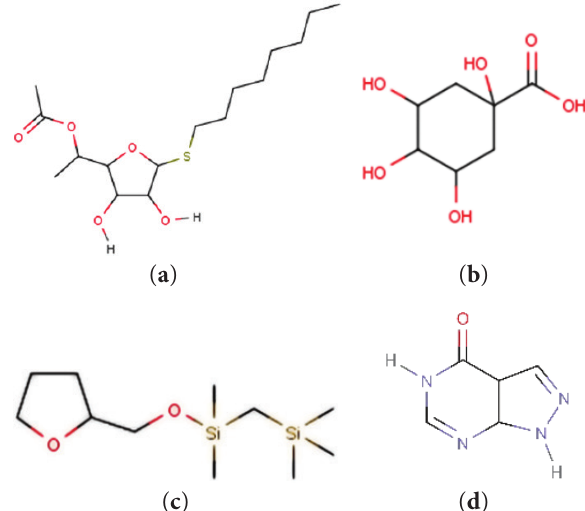
Figure 1. The compounds’ chemical structure of ( a ) 5-O-ace- tyl-thio-octyl-β-L-rhamnofuranoside (PubChem ID: 537841), ( b ) Quinic acid (PubChem ID: 6508), ( c ) 2-Dimethyl(trimeth- ylsilylmethyl)silyloxymethyltetrahydrofuran (PubChem ID: 559105), and ( d ) Allopurinol (PubChem ID: 135401907) as the positive control.